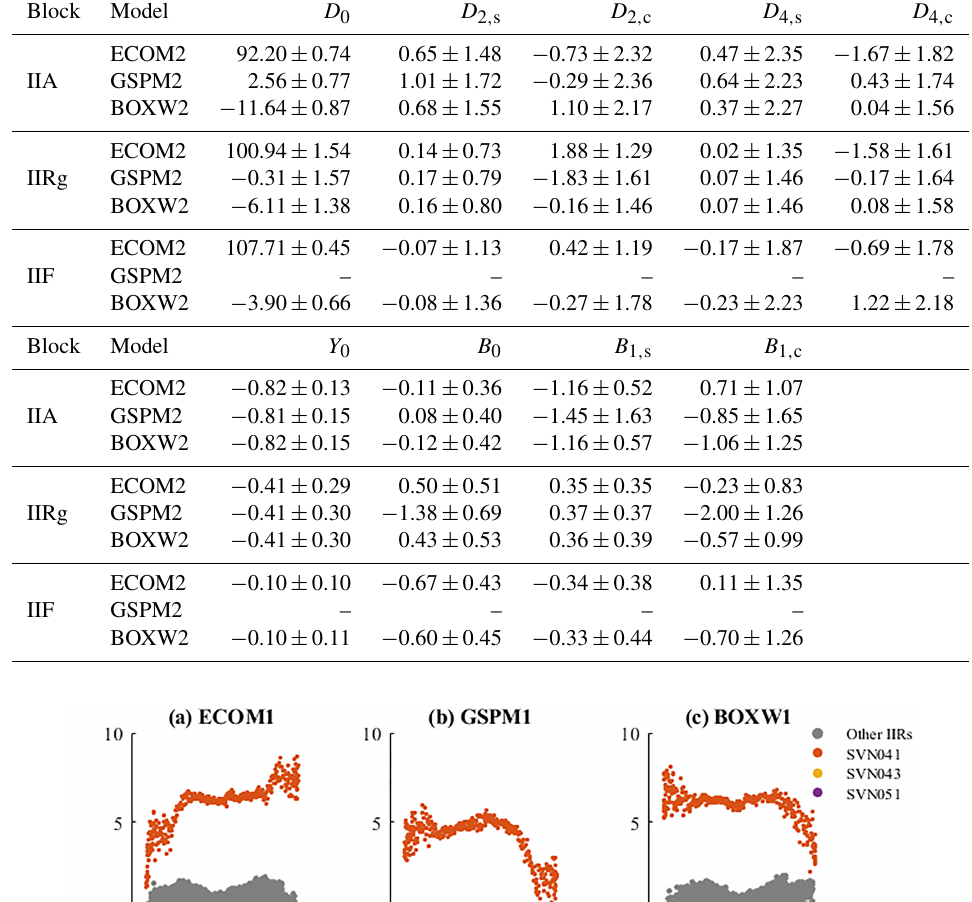
Table 4. The mean and standard deviations of estimated parameters based on ECOM2 parameterization (unit: nms − 2 ).